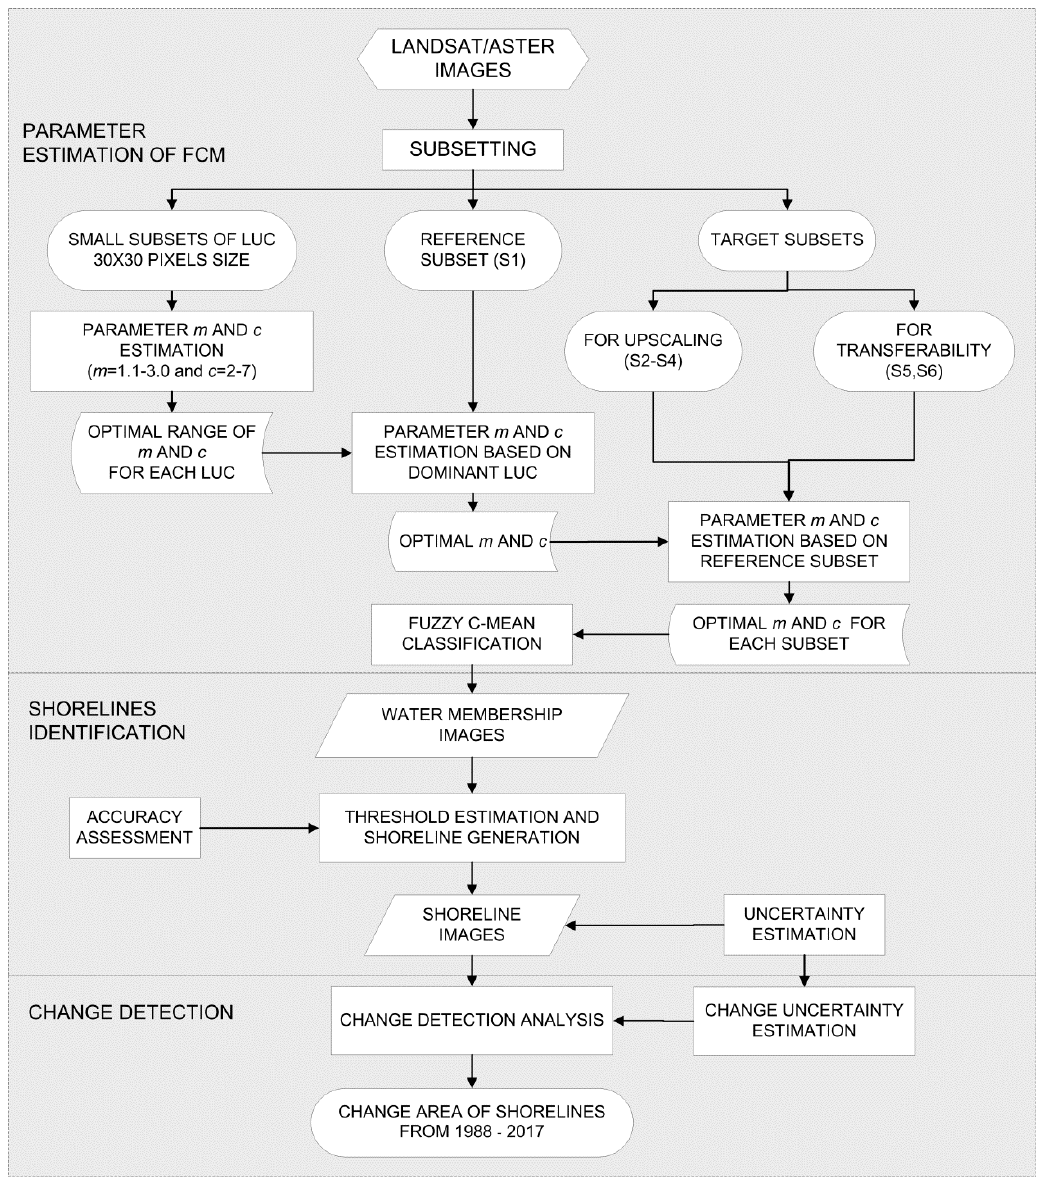
Figure 6. Workflow implemented for upscaling and testing transferability of the method.